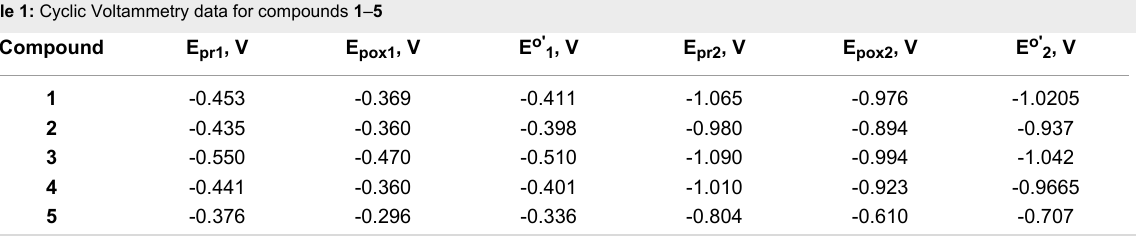
α-methyl groups, symmetric with respect to the plane of the benzene ring (conformation A , Figure 2). In addition, we present computational results for the alternative conformation of 2 with two methyl groups oriented toward the quinone ring (conformation B , Figure 3). To minimize steric repulsion in the alternative conformation of the trimethoxy-derivative 3 , only the methyl group remote from the quinone methoxy-group was oriented toward the quinone ring. These alternative conforma- tions are marked with asterisk in the Table 1 and in the following text and